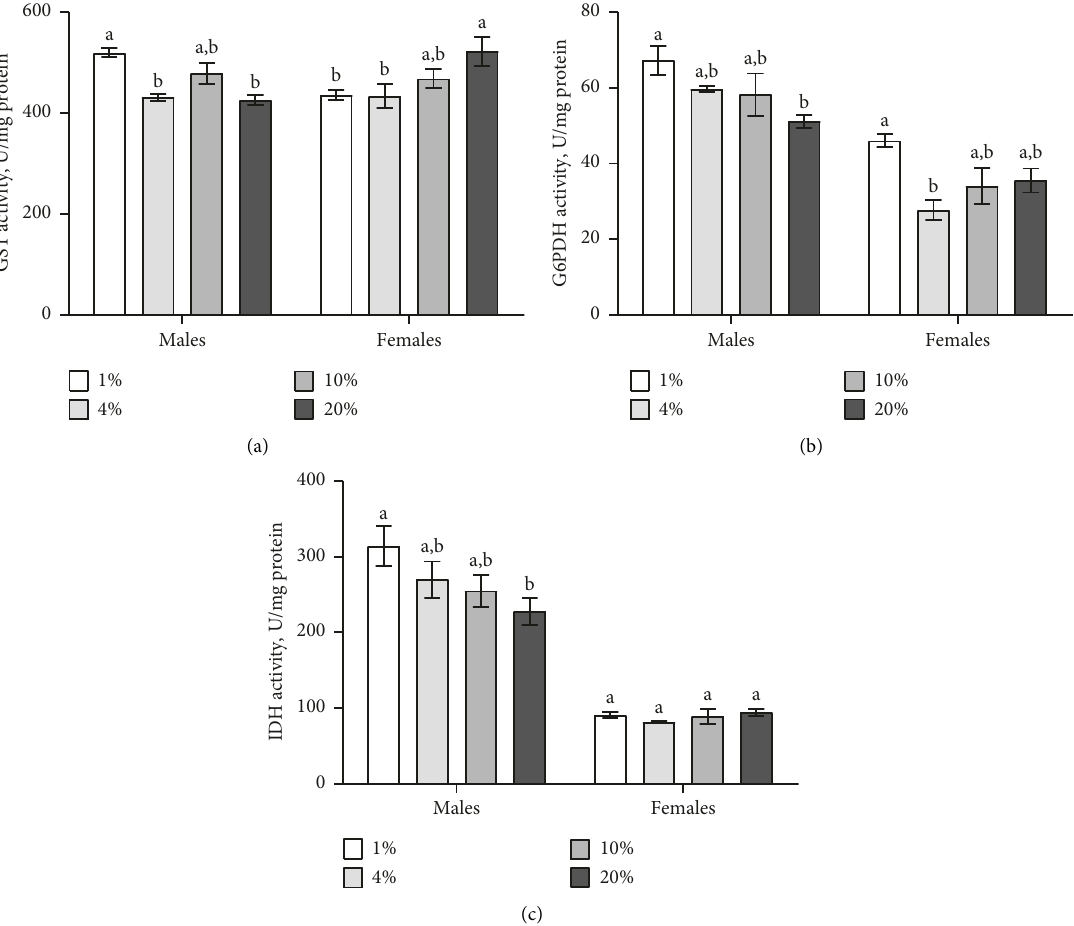
Figure 4: Effect of dietary sucrose in the diet on the activities of GST, NADP-dependent G6PDH, and IDH. Results are shown as mean ± SEM, n � 4. Values were compared by Tukey’s test: a indicates the highest mean among all tested groups; b indicates a significant difference from a with p < 0 .